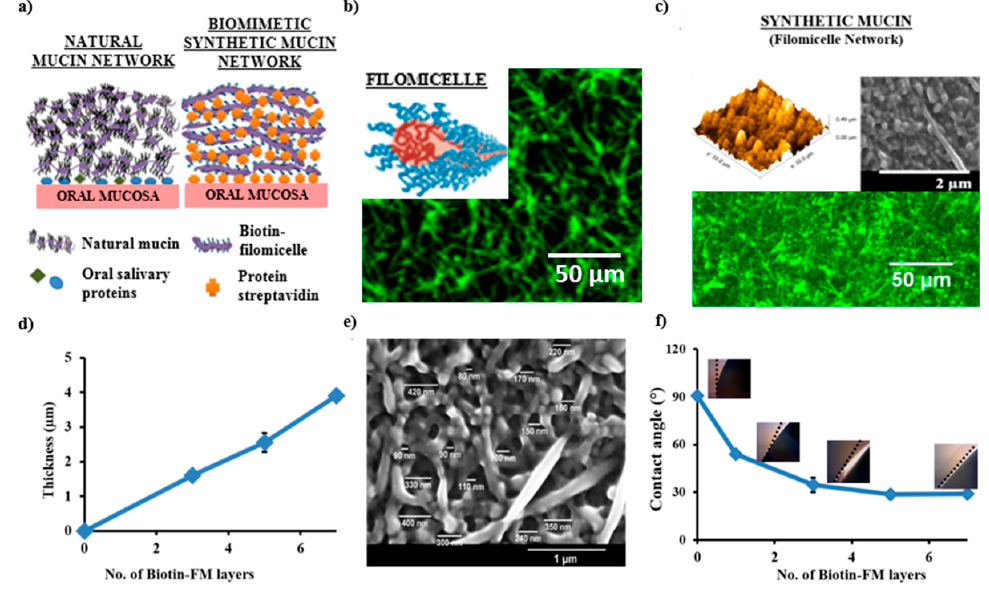
Figure 8. Synthetically derived mucin mimetic system formed from controlled Layer-by-layer (LBL) deposition of polymeric filomicelle, and its structural and functional relevance to natural mucin networks. ( a ) Overall simplified scheme showing natural mucin networks and biomimetic synthetic counterpart (filomicelle networks); ( b ) Fluorescence microscopic visualization of curcumin encapsulated biotinylated filomicelle. Similar to glycoprotein chains in natural systems, the filamentous micelles forms key building block in formation of synthetic networks; ( c ) Morphological relevance of natural mucin structures with synthetic mucin networks formed from filomicelle LBL depositions; ( d ) Controlled thickness growth in synthetic mucin networks can be achieved, by adjusting the number of LBL depositions. Figure shows during filomicelle network, where even with relatively lesser no. of micelle LBL additions (~7), network with significant barrier thickness (~4 um) is achieved; ( e ) Filomicelle networks mimicked the nanoporous mesh size (average range ~110–340 nm) observable in the natural mucin; ( f ) Synthetic mucin networks formed from PEG-based diblock copolymers displayed excellent surface hydration tendency. With synthetic mucin network depositions, the hydrophobic polystyrene (model synthetic interface) translated into a more hydrophilic, hydrating surface, this can be observed with lowering of contact angle from gonimetry study. Reprinted with permission from Reference [84] (Copyright 2015, Wiley-VCH Verlag GmbH & Co. KGaA, Weinheim), and [15] (Copyright © 2014, American Chemical Society). The filomicelle network barrier thickness can be increased with a relatively fewer number of LBL